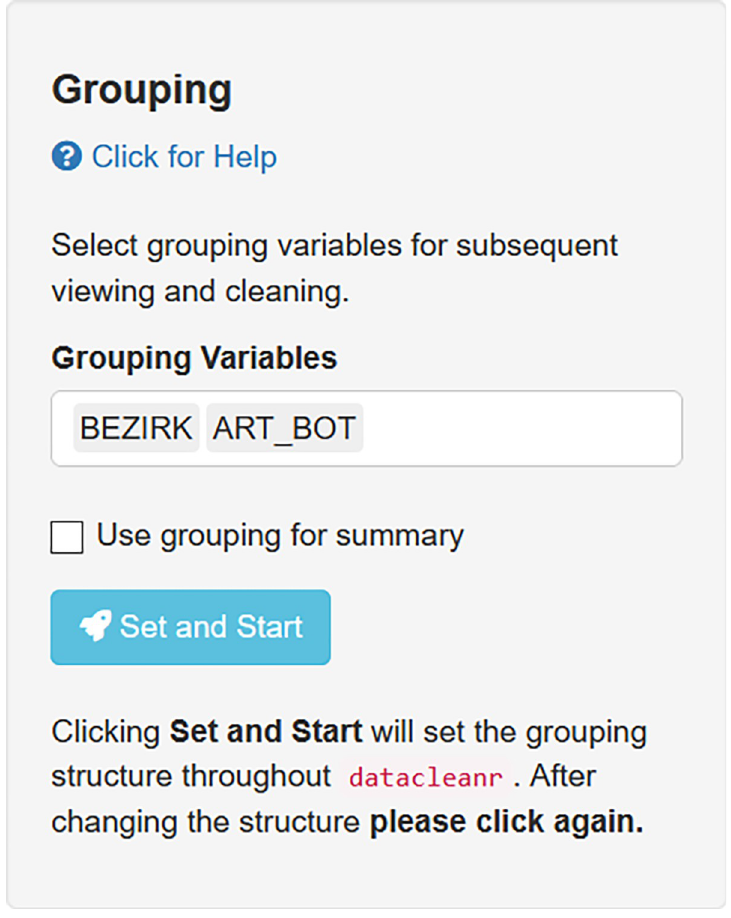
Fig 6. Example set-up for hierarchically nested data. Grouping structure set to district (BEZIRK) and species (ART_BOT) in “Set-up and Overview” tab for subsequent exploration, plotting and